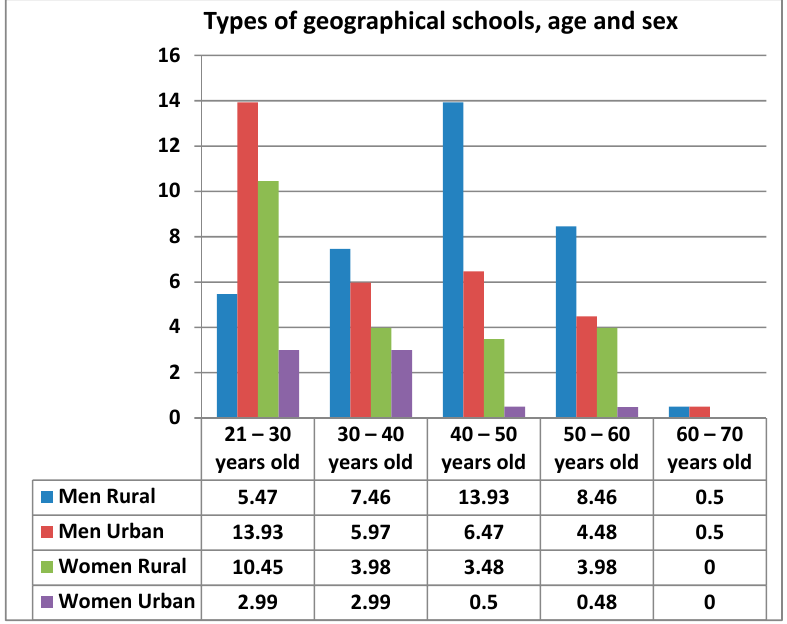
Figure 4. Relationship by types of geographical schools, age and sex.